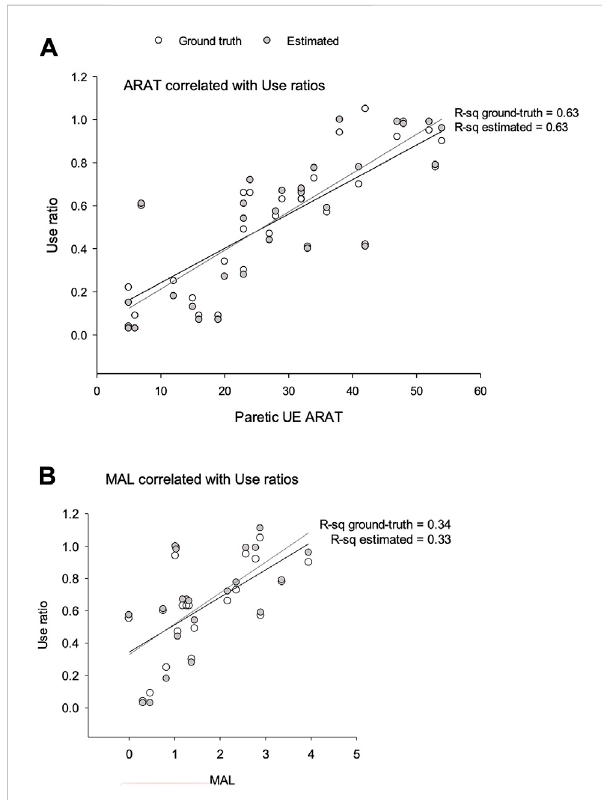
FIGURE 2 Scatter plots of video-labeled or estimated use ratios with (A) ARAT and (B)